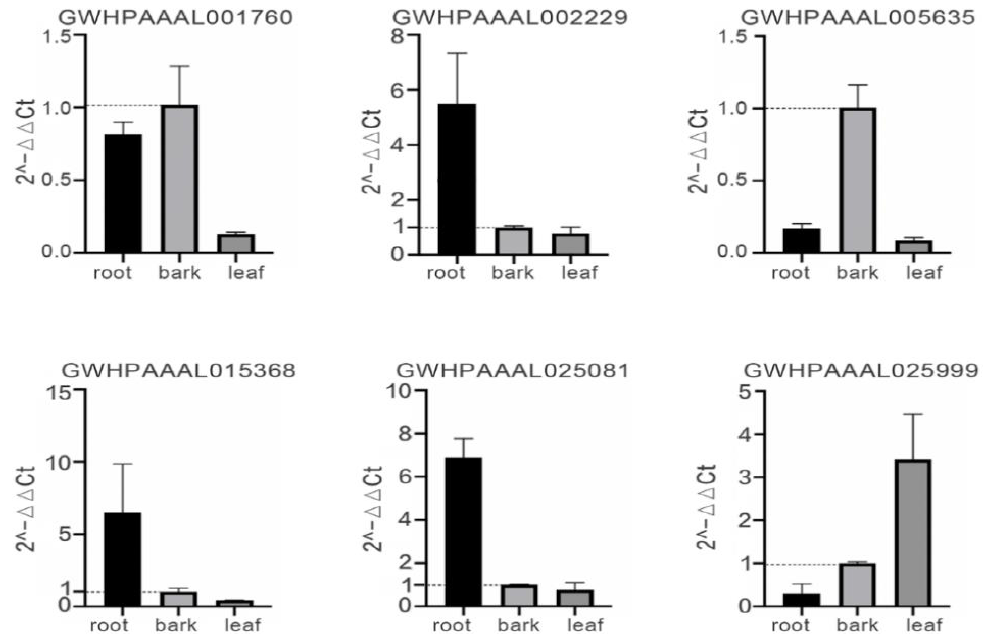
Figure 7. Quantitative real-time PCR analysis of six selected Eu UGT genes in root, bark, and leaves of E. ulmoides. The relative expression level of each Eu UGT gene was normalized to that in the bark. The β -actin was used as the reference gene.